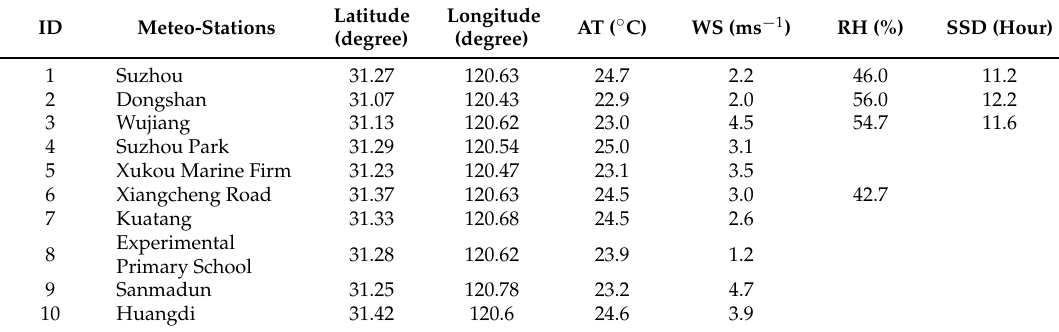
Table 1. Summary of the meteorological conditions (at a 2-m height) at 1040 local time on 24 May 2010 for Suzhou. AT, atmospheric temperature; WS, wind speed; RH, relative humidity; SSD, sunshine duration.